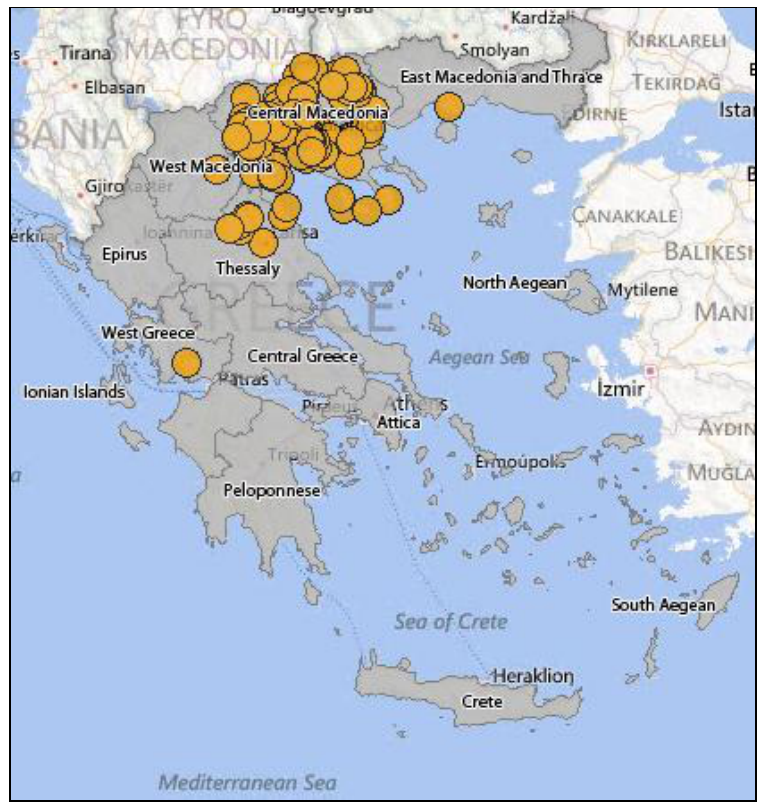
Figure 6. WNV human cases in Greece, 2010.